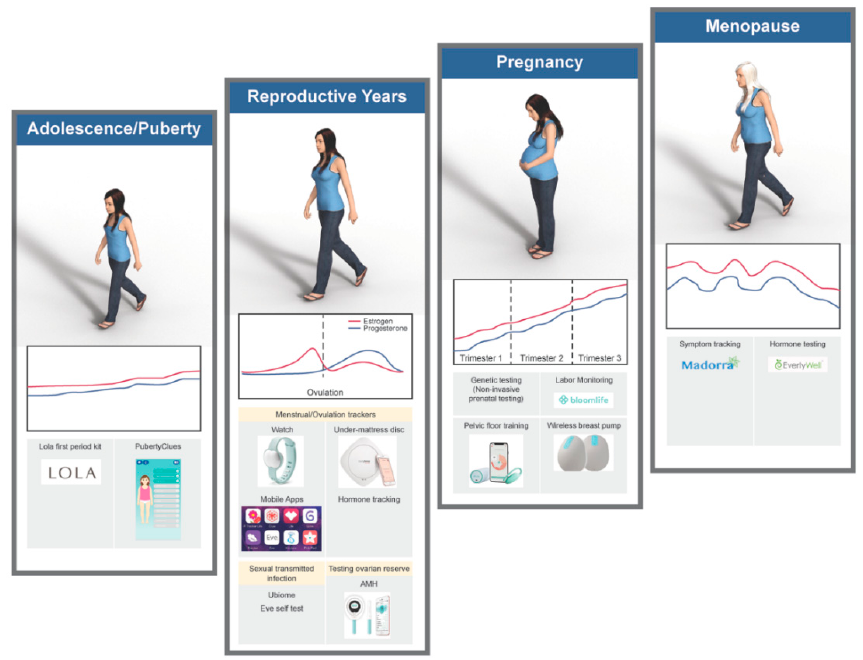
Figure 2. Lifestyle and hormone cycles with applicable technologies.